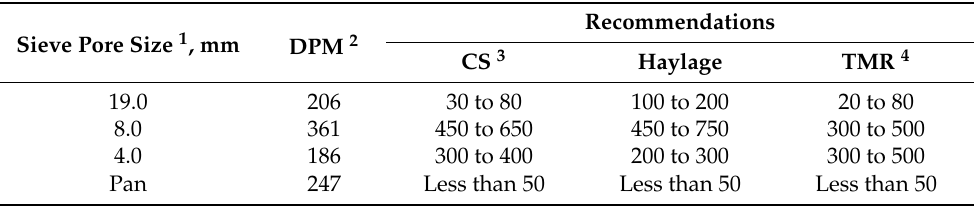
Table 4. Particle size distribution, g kg − 1 , of dried paunch manure compared with recommendations for corn silage, haylage, and total mixed rations (adapted from